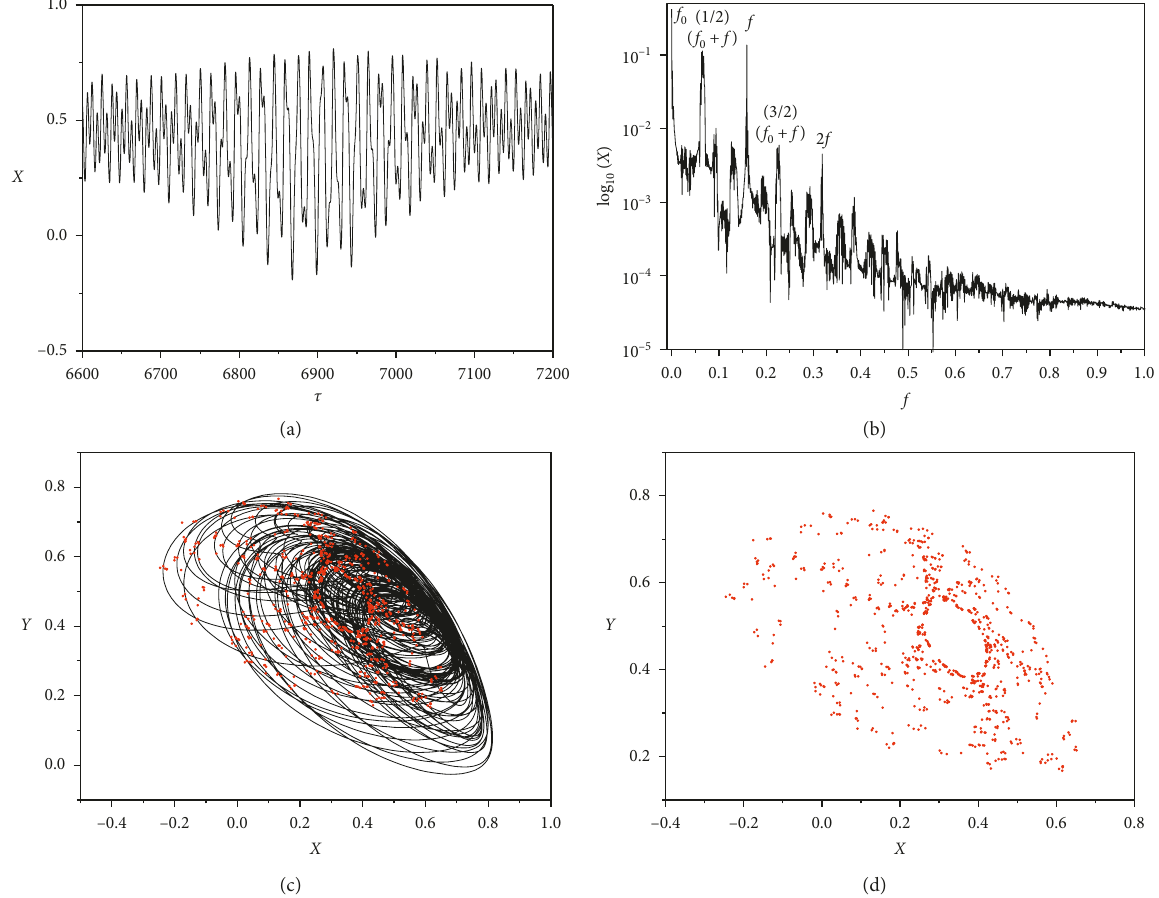
Figure 9: (a) Displacement. (b) Frequency response. (c) Rotor orbit. (d) Poincar´e map where